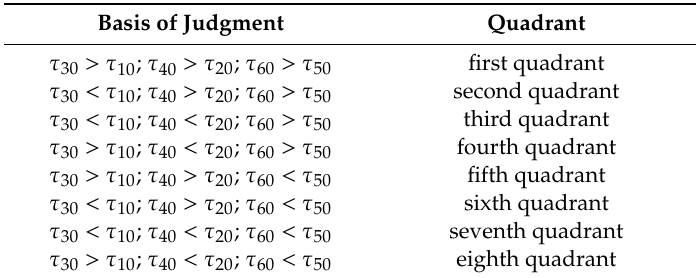
Table 1. Criteria for judging the sound source position